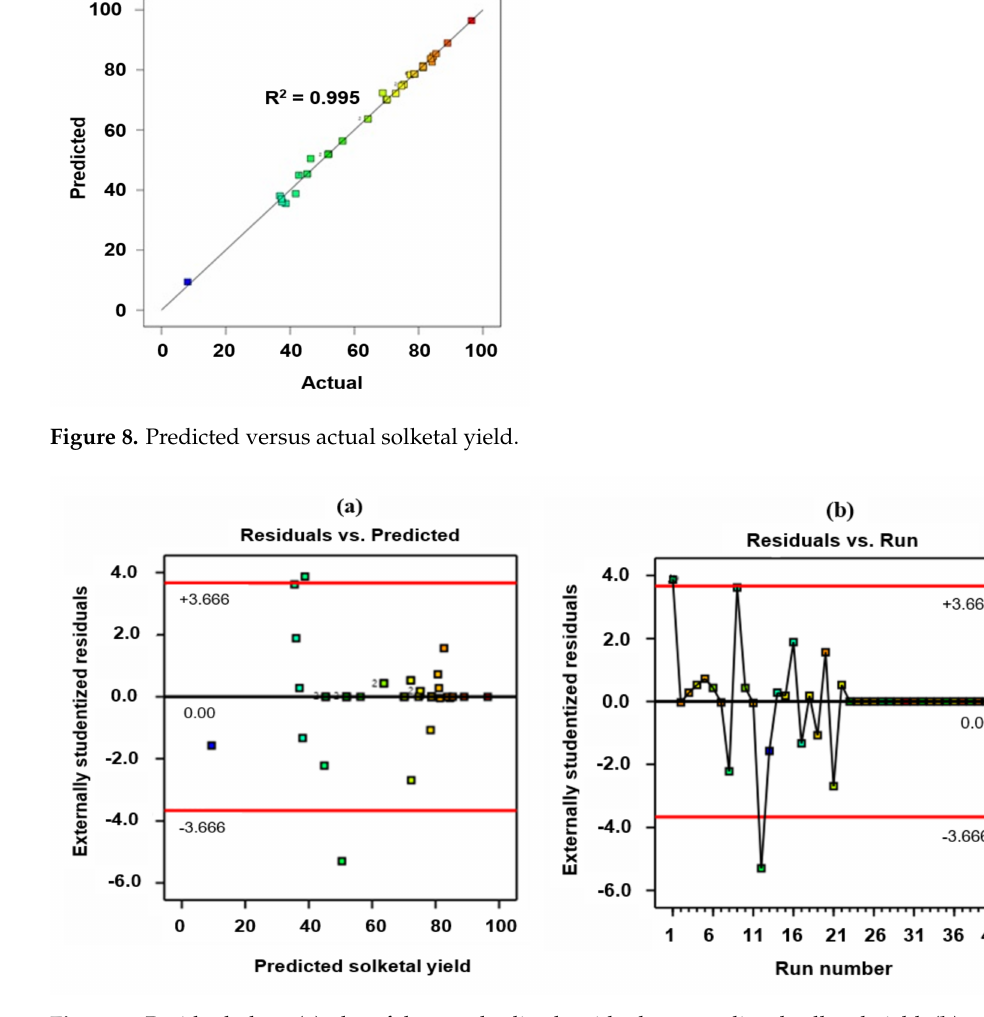
Figure 9. Residual plots: ( a ) plot of the standardized residuals vs. predicted solketal yield, ( b ) outlier t